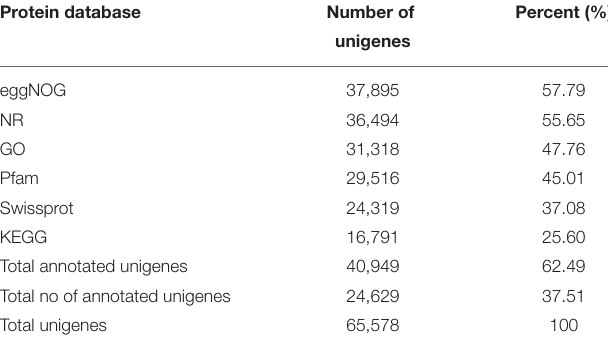
TABLE 2 | Statistics of annotated unigenes from six